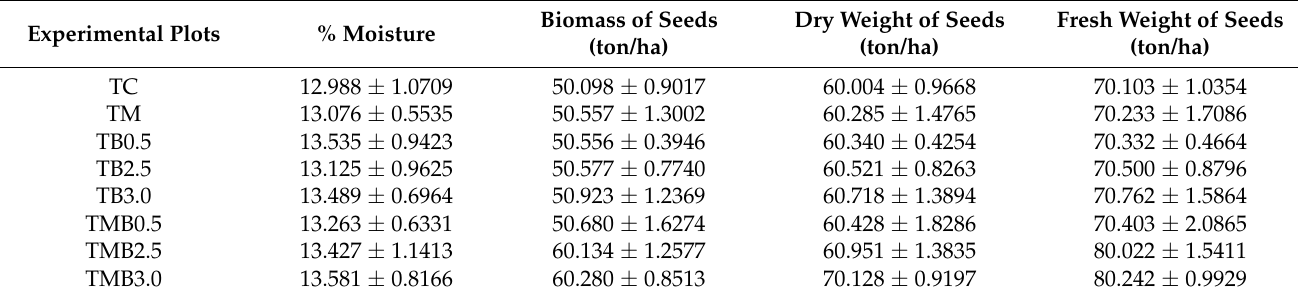
Table 3. The maize yield and productivity from different experimental plots. Experimental